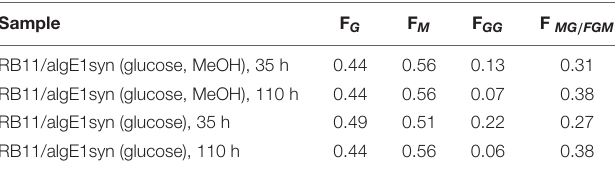
TABLE 2 | NMR analyses of polyM epimerized with AlgE1-containing samples from fermentations of RB11/algE1syn showed in Figure 1